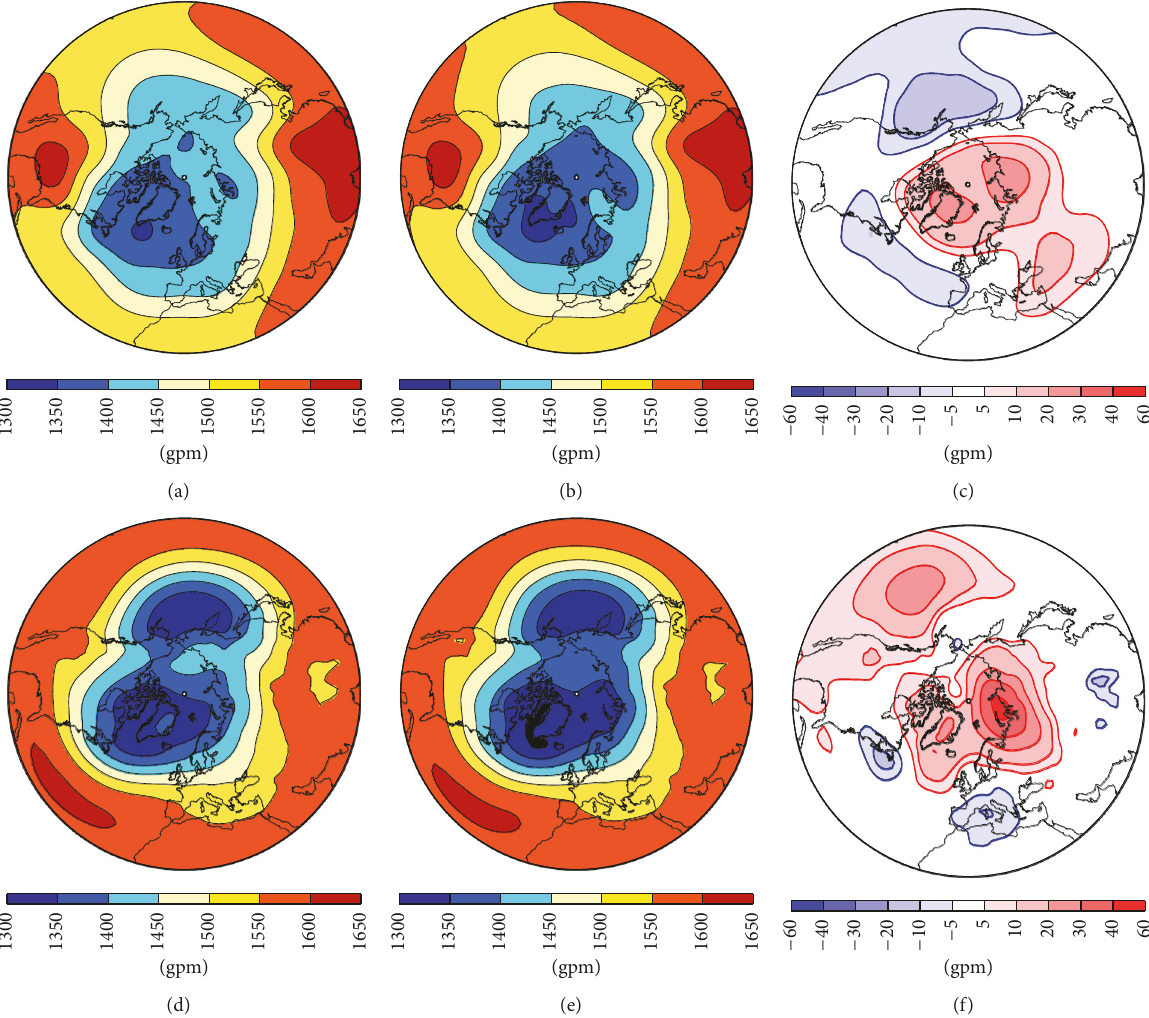
Figure 3: Mean geopotential height (gpm) of the 833 hPa model level ((a), (b), and (c)) and from the layer-averaged ERA-Interim reanalysis data ((d), (e), and (f)). At each row, the figures correspond to the low ((a) and (d)) and high ((b) and (e)) Arctic sea-ice-cover conditions and ((c) and (f)) to their difference (low minus high)